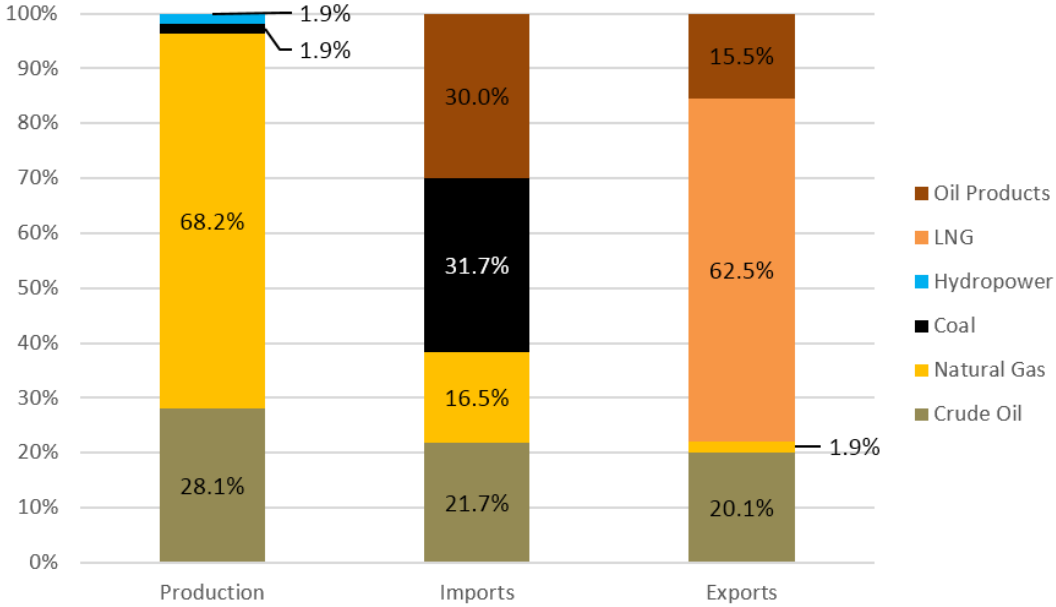
Figure 4. The structure of Malaysia’s energy production, imports and exports in